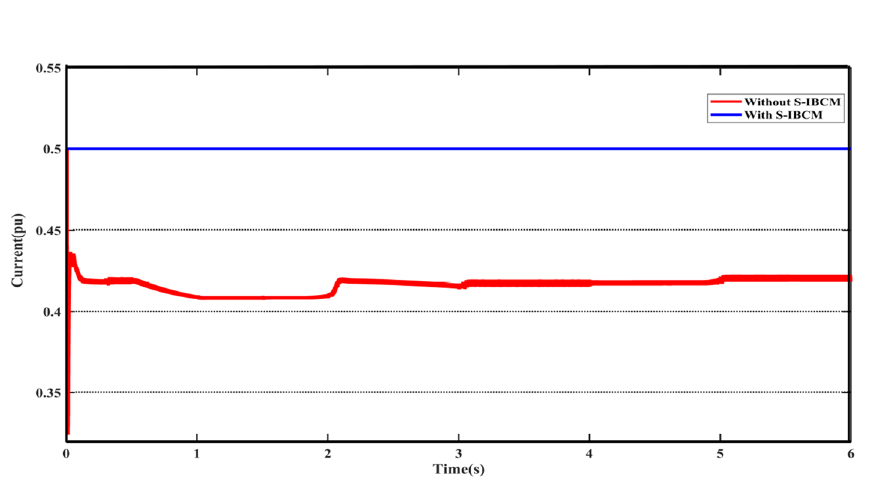
Figure 11. The open view of the DCMG terminal voltage with and without S-IBCM.